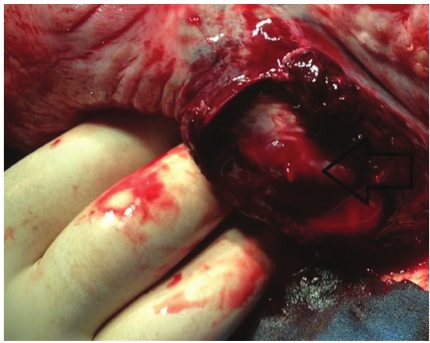
Figure 2: Artery was sutured with Vicryl 1.0. Arrow indicates incision side of the